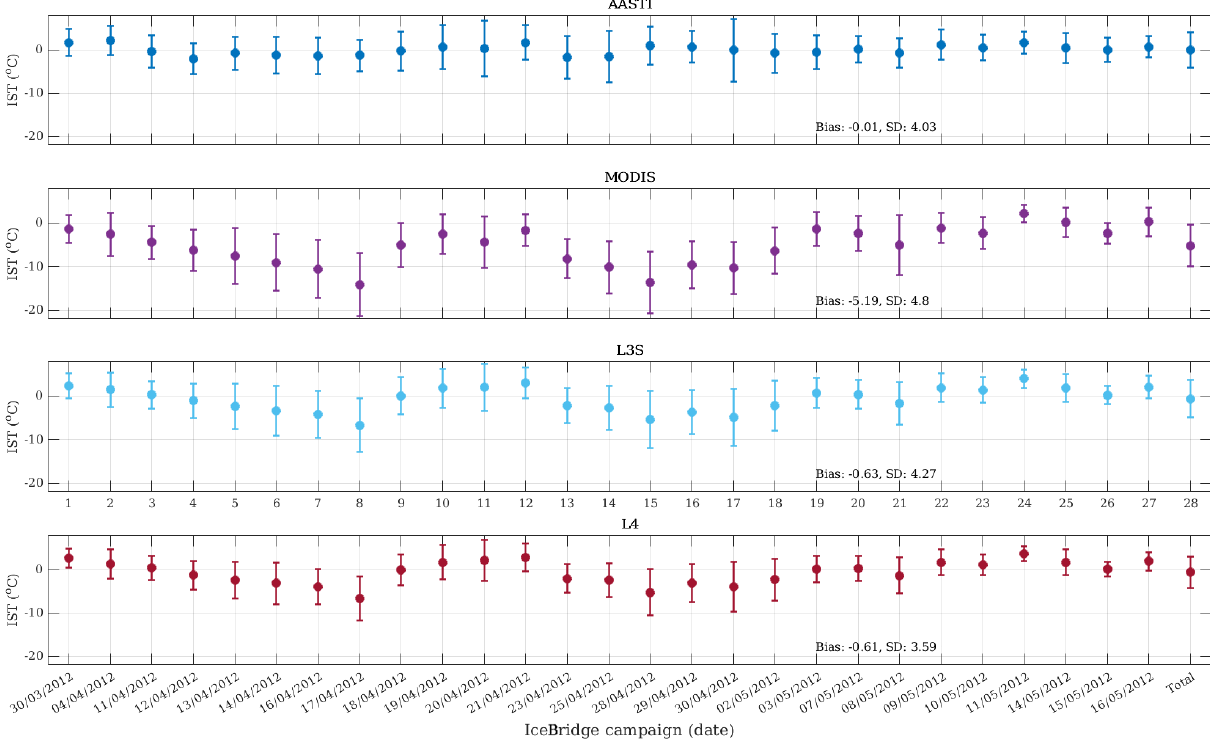
Figure 7. Mean bias (dots) and standard deviation of errors (bars) for the AASTI, MODIS, L3 IST and L4 IST products against individual IceBridge flight observations from March to May 2012. The total bias and standard deviation values are